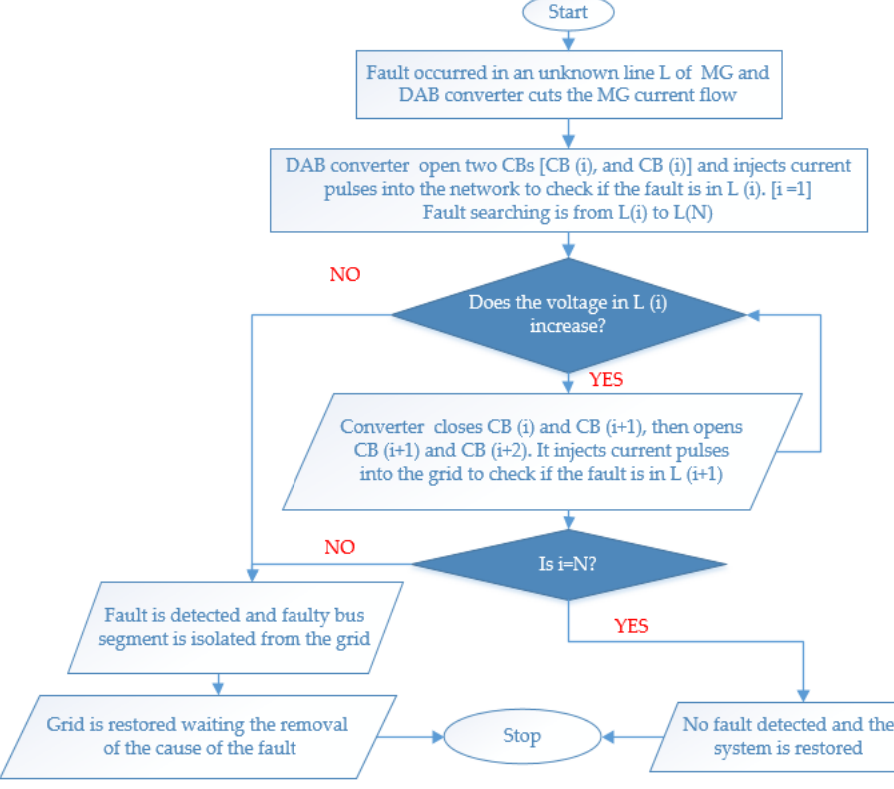
Figure 6. Fault detection using line fault search by opening and closing two nearby CBs.